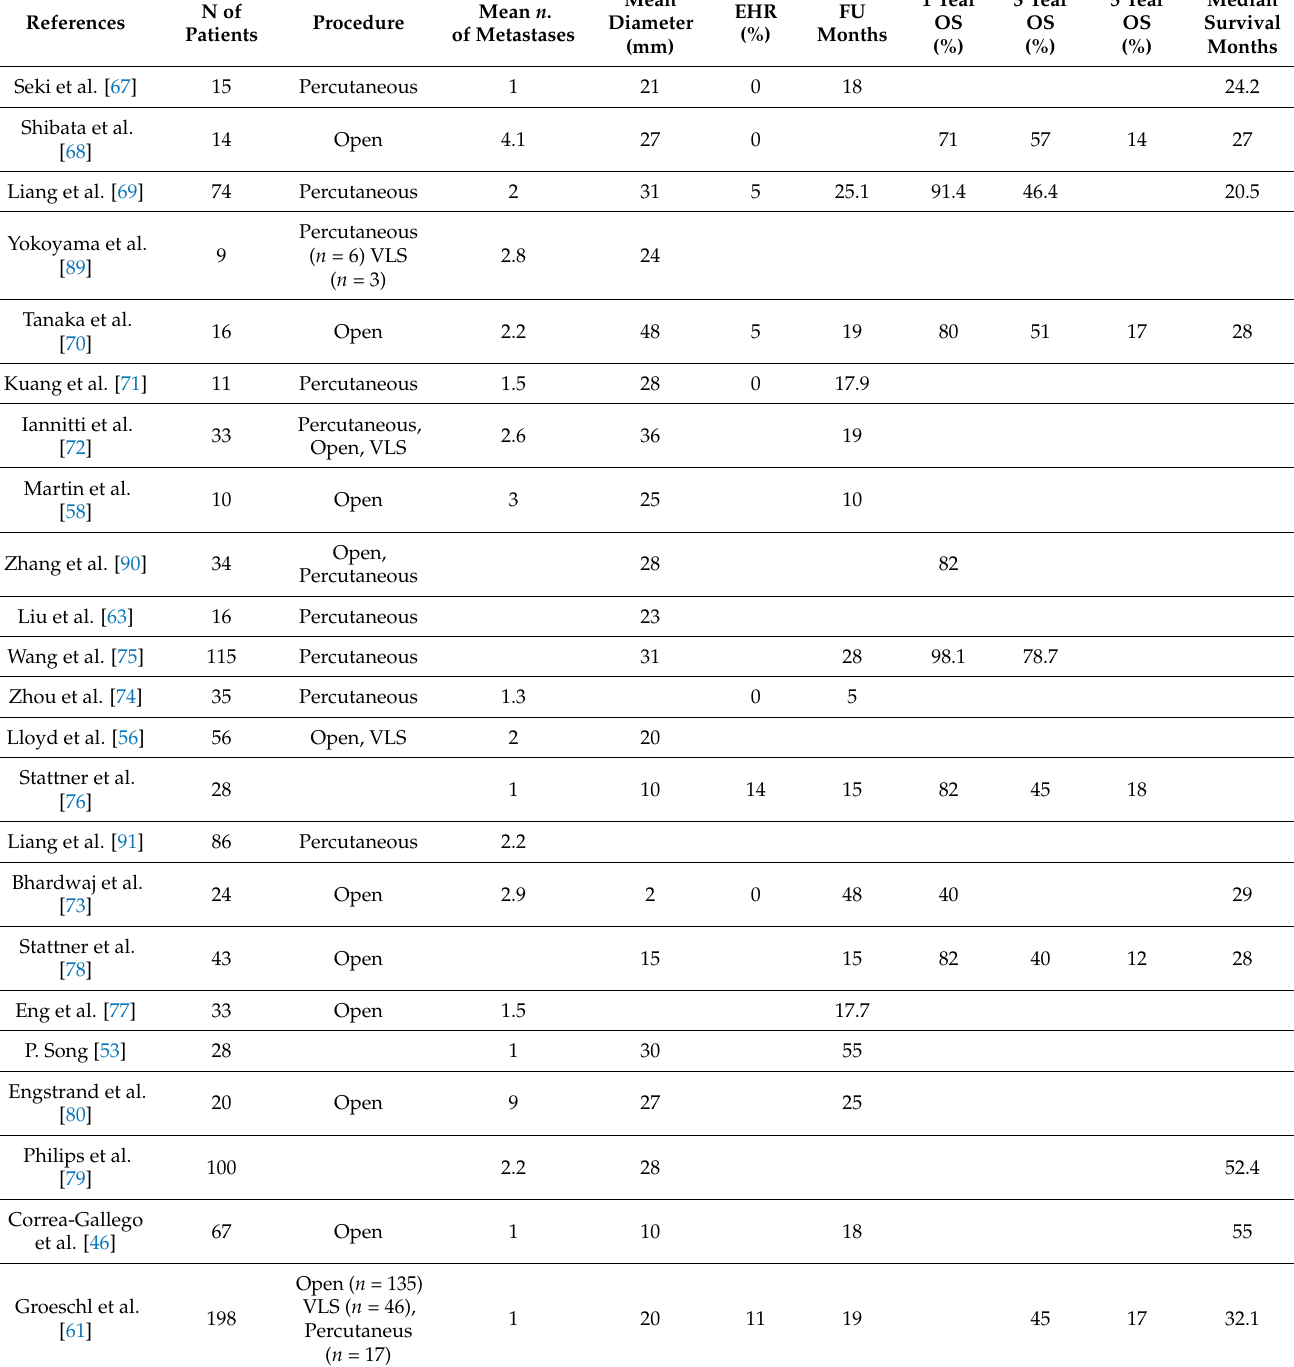
Table 4. Overall Survival after MWA for CRLM: a review of the